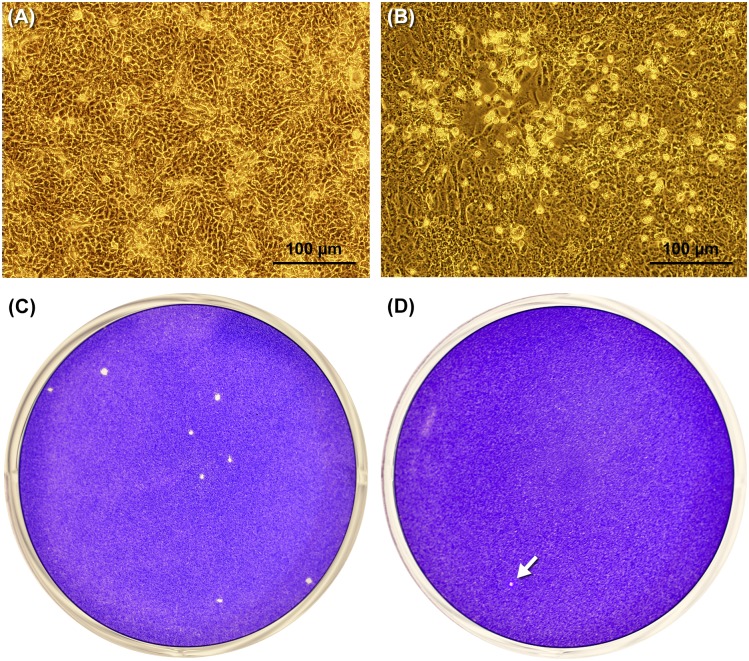
Isolation of Zika virus in Vero cell from the saliva of patient 6.Phase contrast optical microscopy of culture flasks containing (A) Mock-infected Vero cells and (B) saliva-infected Vero cells presenting a clear visible cytopathic effect. Viral plaque detection in saliva (C) and urine (D). The white arrow shows the unique viral plaque detected in the urine sample.